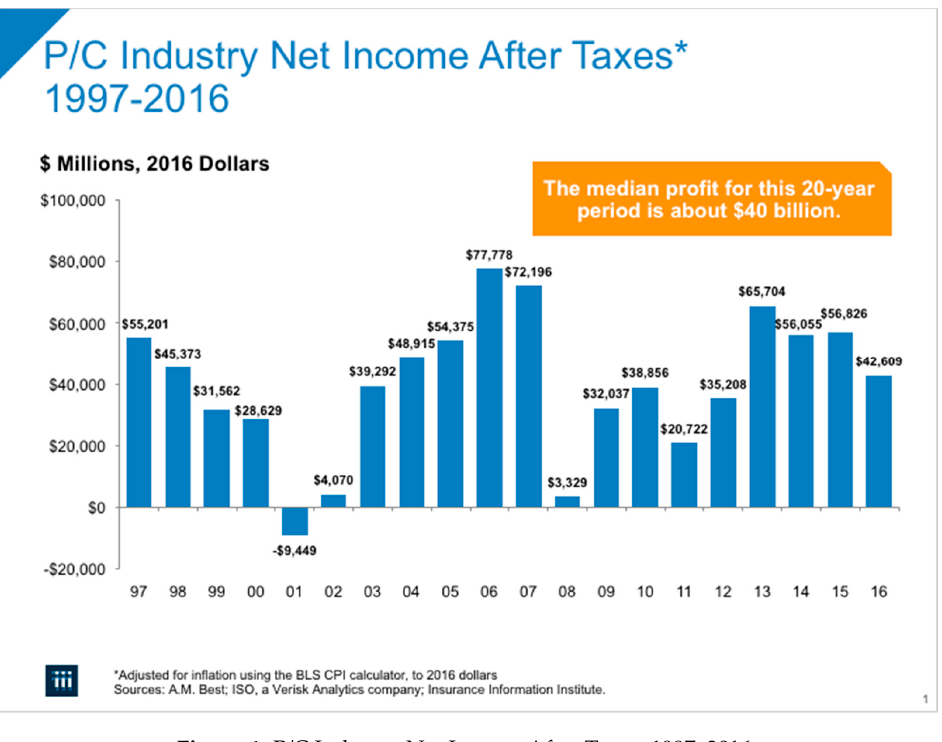
Figure 4. P/C Industry Net Income After Taxes, 1997–2016.